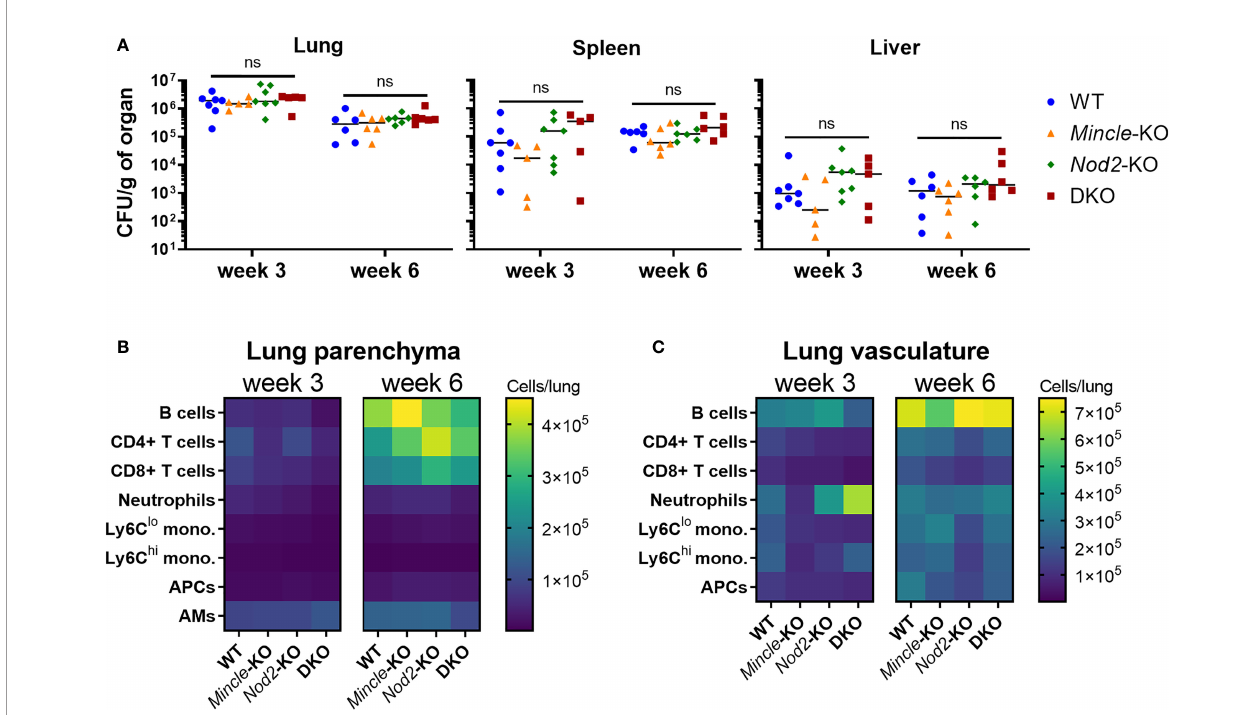
FIGURE 3 | Mtb burden and leukocyte recruitment in mice lacking Mincle and Nod2 singly and in combination. (A) , Mtb burden per gram of left lung (left), spleen (middle) and liver (right) at week 3 (day 22) and week 6 (day 43) post-infection. No statistically signi fi cant differences ( a = 0.05) were found between genotypes using Kruskal-Wallis tests (ns, not signi fi cant). (B, C) , absolute numbers of pulmonary leukocytes at the indicated timepoints post-infection. Using intravenous anti-CD45-FITC staining just prior to euthanasia, parenchymal (CD45-FITC - ) (B) or vascular (CD45-FITC + ) (C) location was determined. See Figure S3 for statistical comparisons of populations. Median day 1 pulmonary Mtb load was 15 CFU. Shown are medians for N = 5 to 7 mice per group per